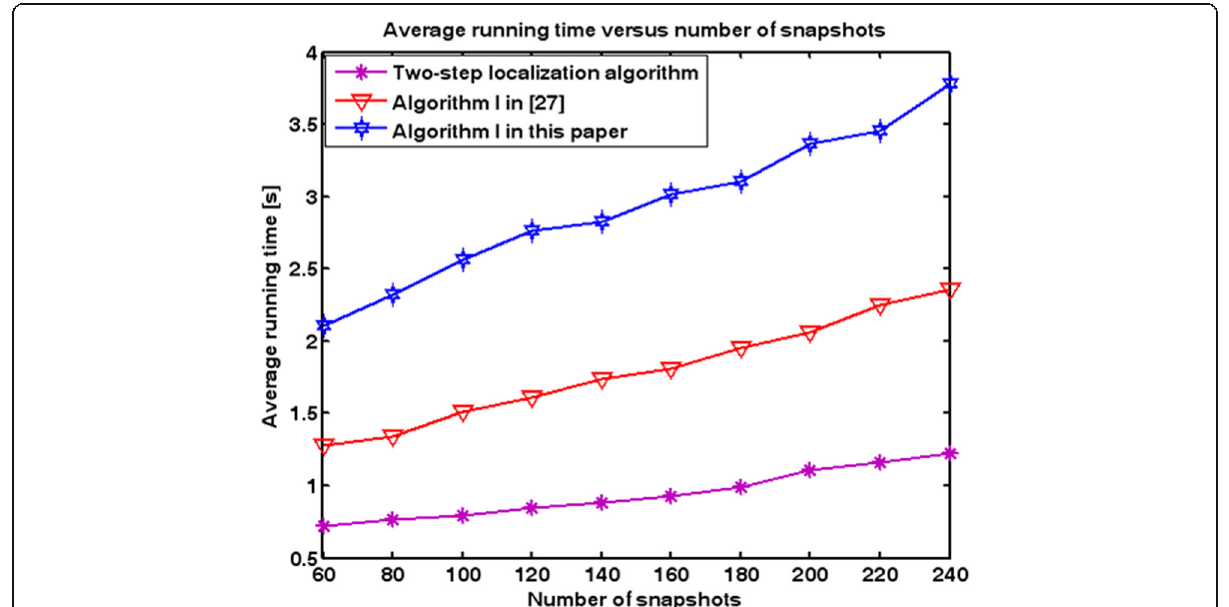
Fig. 13 Average running time as a function of the snapshot number (the first simulation